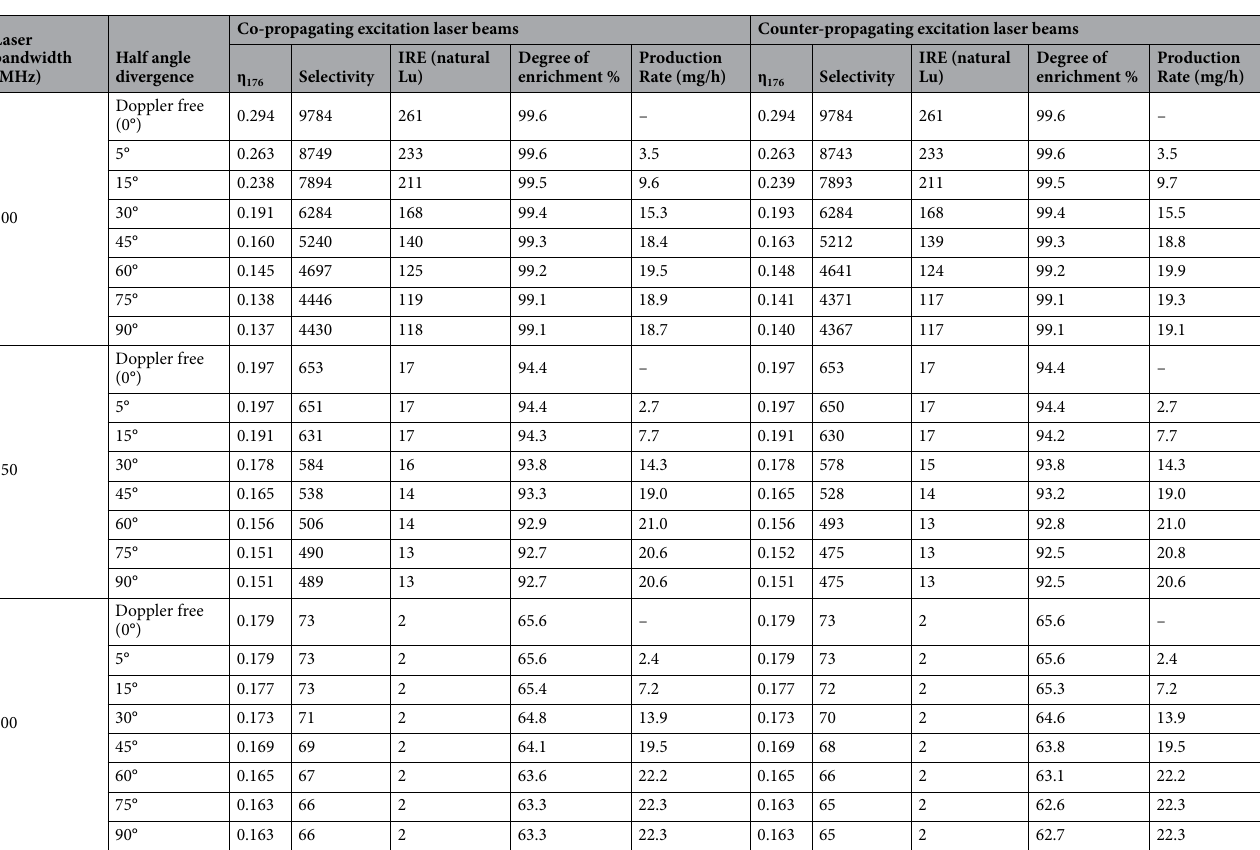
Table 4. A table of degree of enrichment and production rates of 176 Lu for various experimental parameters. Production rates are calculated for the atomic number density of 5 × 10 14 of Lu. (corresponding to the number density 1.3 × 10 13 of 176 Lu); length of the laser-atom interaction region 200 mm, laser beam diameter of 10 mm.